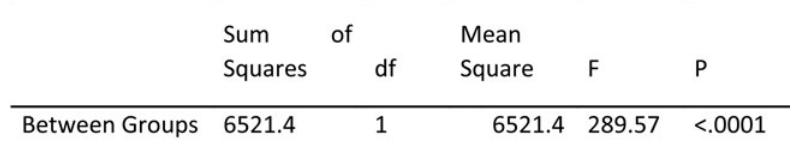
Fig. 6. ANOVA of Wave 3 v Wave